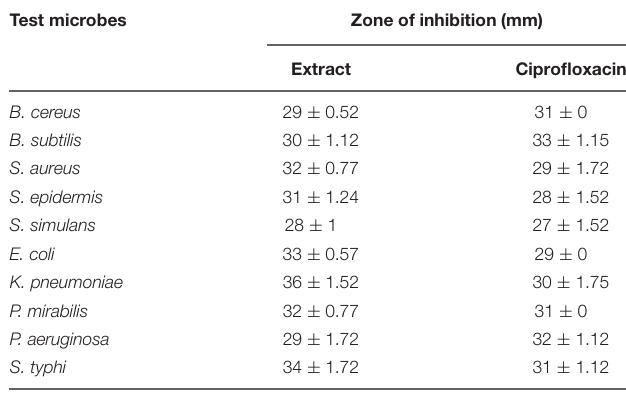
TABLE 5 | Antibacterial activity of crude extract from TSB + Glucose + meat peptone in the best ideal condition. Test